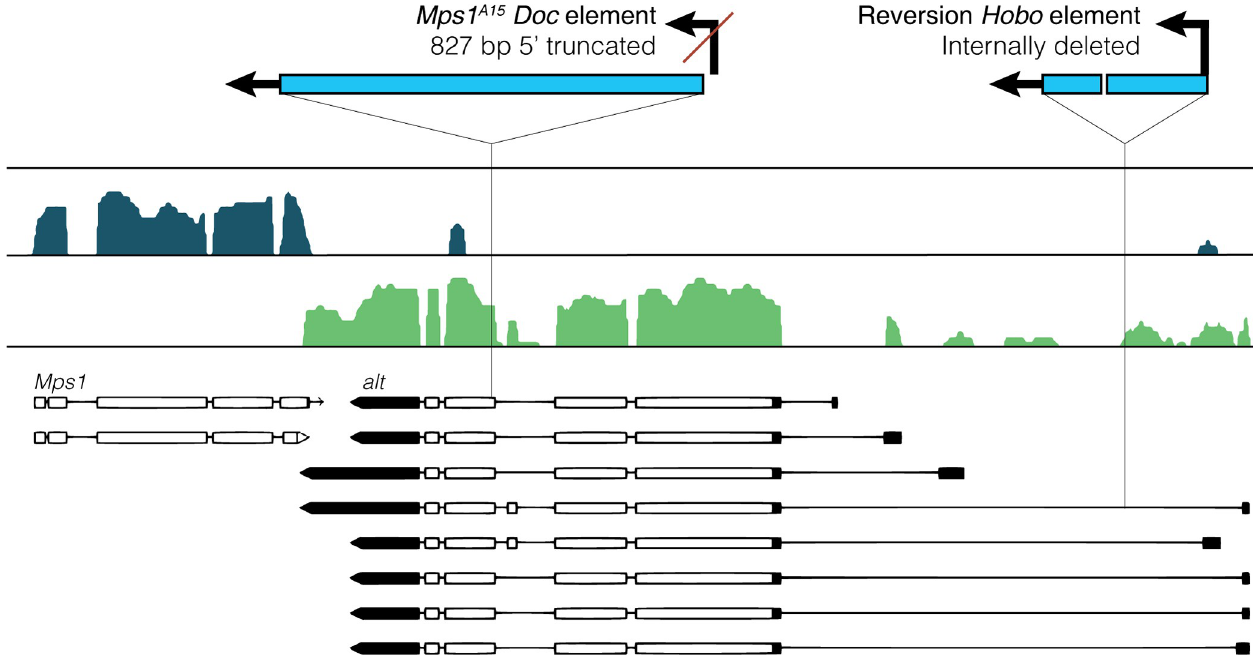
Fig 1. Annotation of TE structure and insertion positions for Mps1 A15 and Mps1 A15 . revertant alleles within alt . Transcript annotations and stranded mRNA- seq mappings from (blue[+] and green [–]density plots) from ovaries of mated females are from Flybase (www.flybase.org) and [56]. The Mps1 A15 Doc insertion is 5’ truncated by 827 bp and located within the 4th/5th exon of alt , in the sense direction of the alt transcript. The Mps1 A15 . rev Hobo insertion is internally deleted, inserted in the sense direction of alt and located in the first intron, 1188 bp from the first alt TSS.